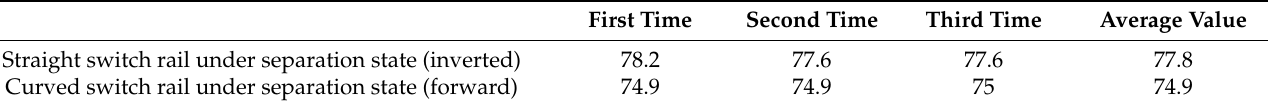
Table 6. Minimum flangeway